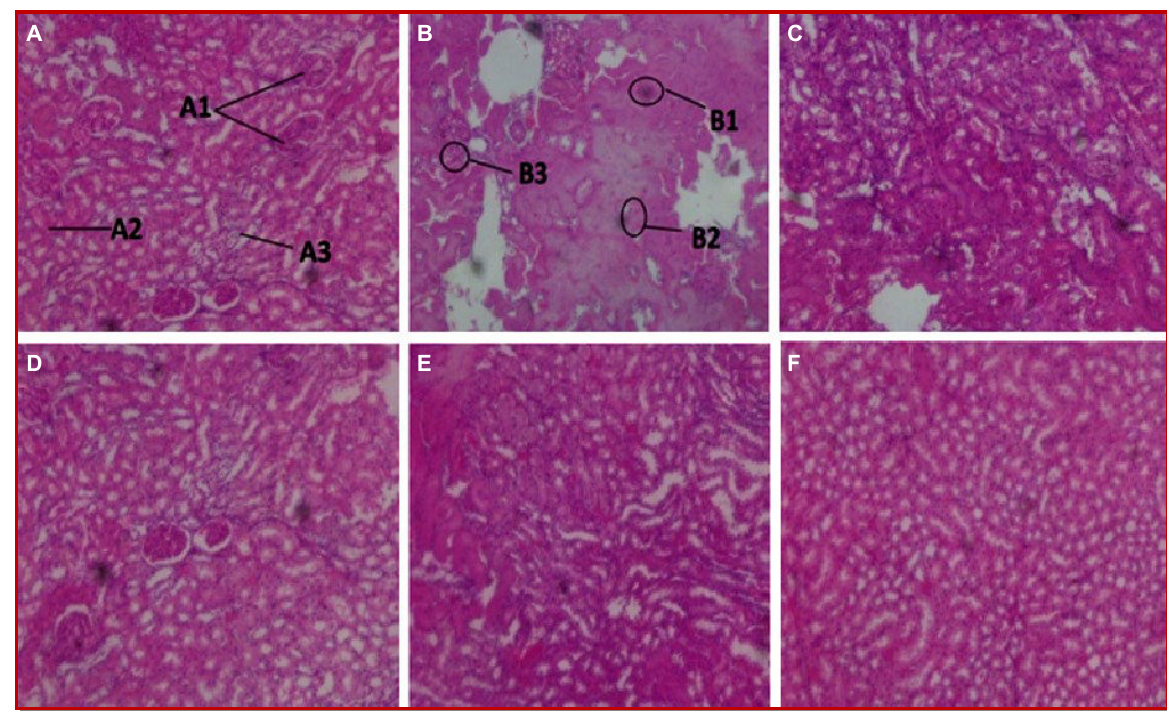
Figure 1 : Light photomicrograph of kidney tissue of rats treated with methanol extract of Berberis lycium in sub-acute study. Hae- matoxylin and eosin, X 400 A: Control kidney, A1: Glomerulus, A2: Proximal tubule, A3: Distal tubule, B: Cisplatin 4 mg/kg, B1: Peritubular congestion, B2: Coagulative necrosis, B3: Degeneration, C: AE-200, D: AE-400, E: CIS + AQ200, F: CIS +